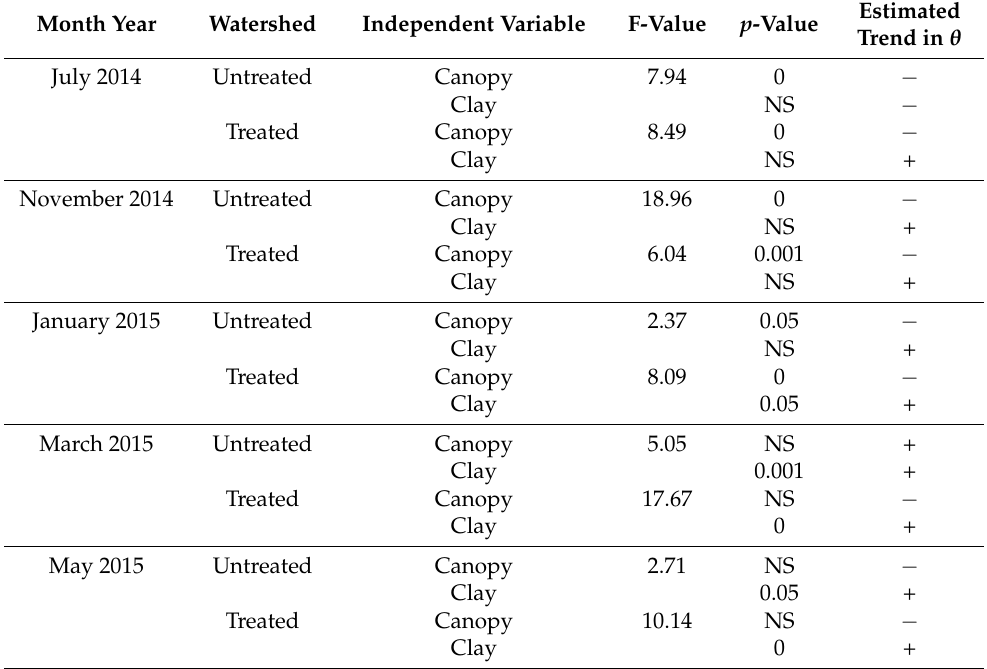
Table 2. Results of the reduced linear model estimating trends in soil volumetric water content ( θ ) under main effects of total canopy cover and clay for each measurement period. (+) estimates positive trend with increasing canopy cover, ( − ) estimates negative trend with increasing canopy cover, (NS) non-significant p